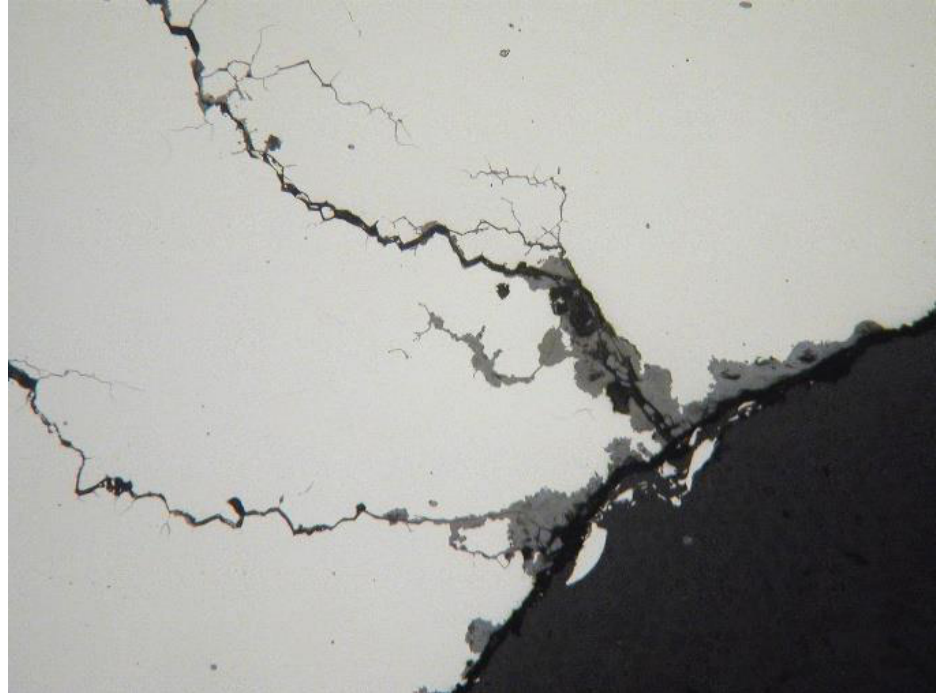
Figure 8. A detail of a large hemispherical etch pit, initiated by the two pre-existing bifilm cracks (rather than the pit initiating the cracks), in a steel blade of a steam turbine Reprinted with permission from ref. [51]. Copyright 2022 Elsevier.